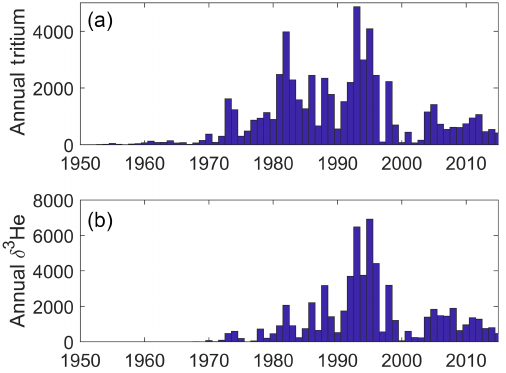
Figure 2. Time distributions of annual tritium (a) and helium (b)